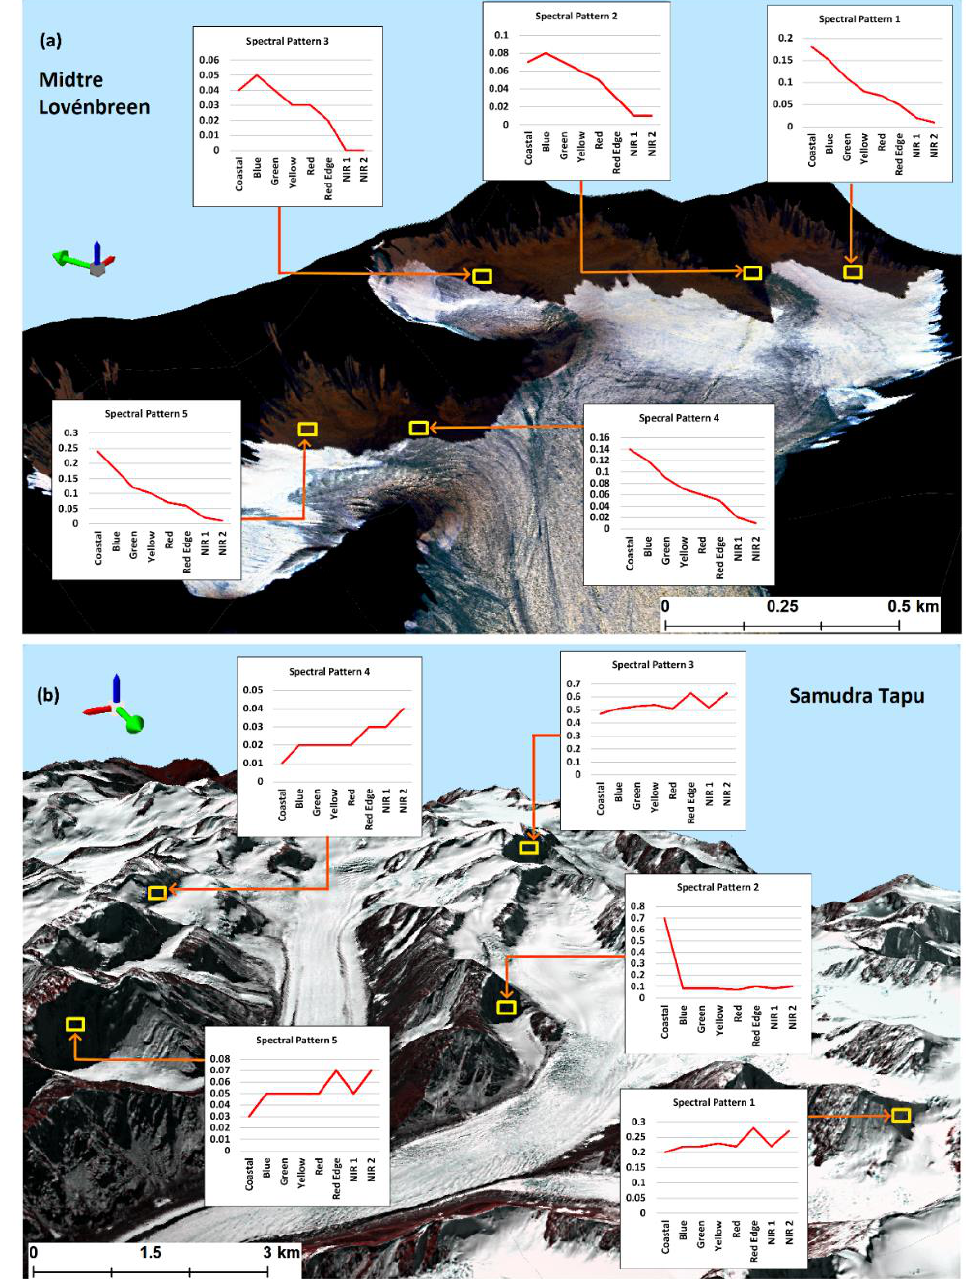
Figure 10. Complex spectral patterns of the shadowed snow at different points on the glacier. Base images are the FLAASH corrected images draped on the ArcticDEM for Ny-Ålesund and ASTER GDEM v2 for Chandra–Bhaga basin. Inset ( a ) 3D surface of glacier ML, ( b ) 3D surface of glacier